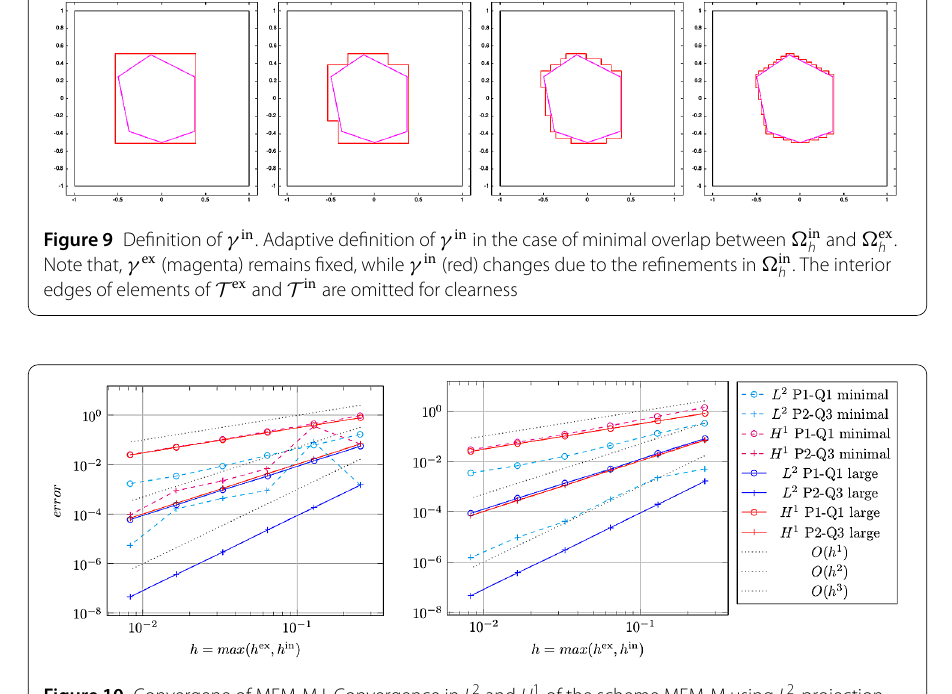
Figure 10 Convergene of MEM-M I. Convergence in L 2 and H 1 of the scheme MEM-M using L 2 -projection (left) or nodal interpolation